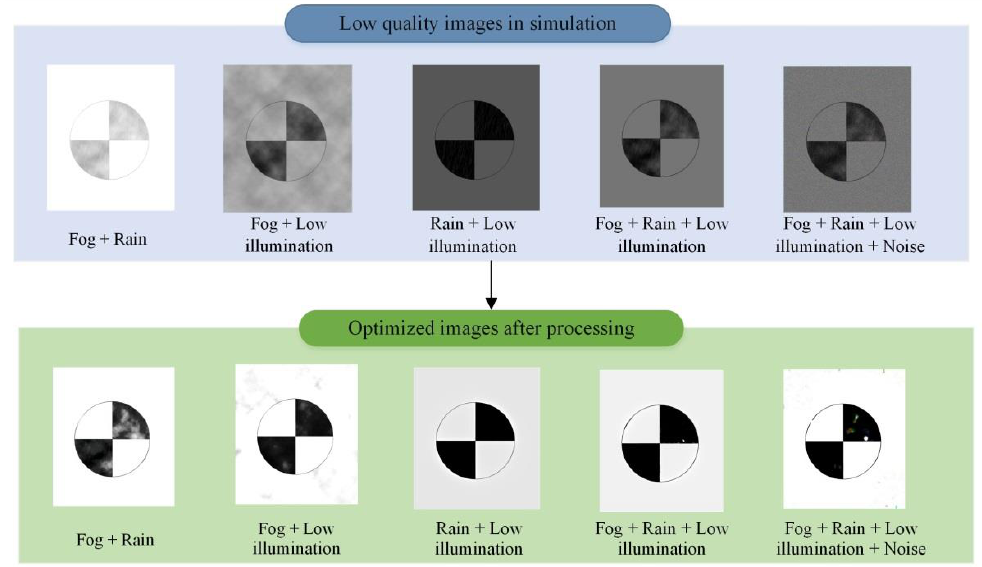
Figure 10. Target center positioning errors under single environment parameter interference before and after processing: ( a ) fog; ( b ) rain; ( c ) low illumination; ( d ) noise.